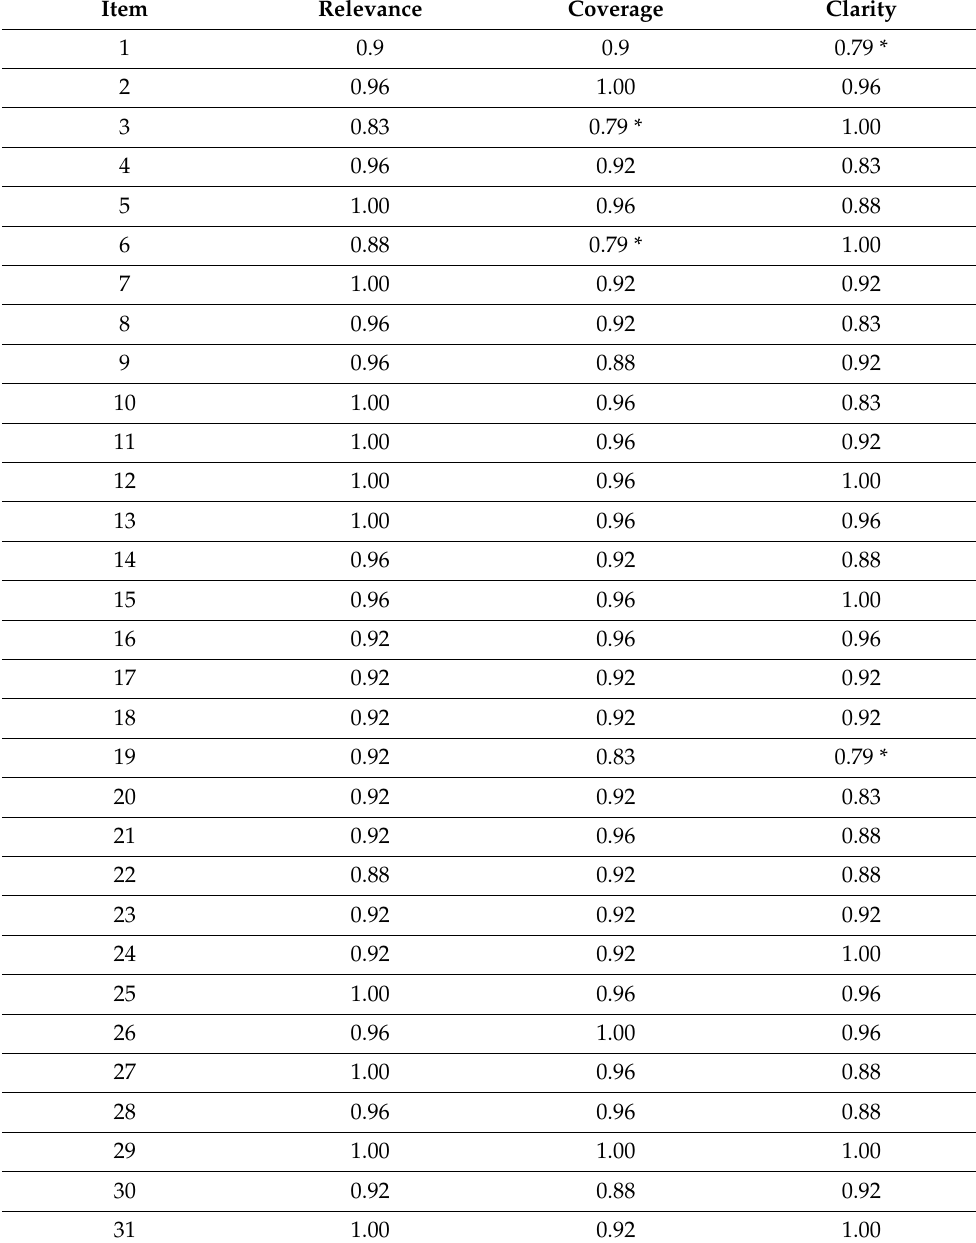
Table 5. Content Validity Coefficient (CVC) results for each item in three aspects judged for Content